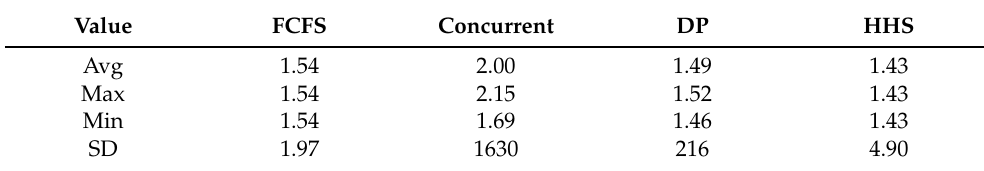
Table 4. Energy consumption statistics of FCFS, Concurrent, DP, and HHS based on the num-